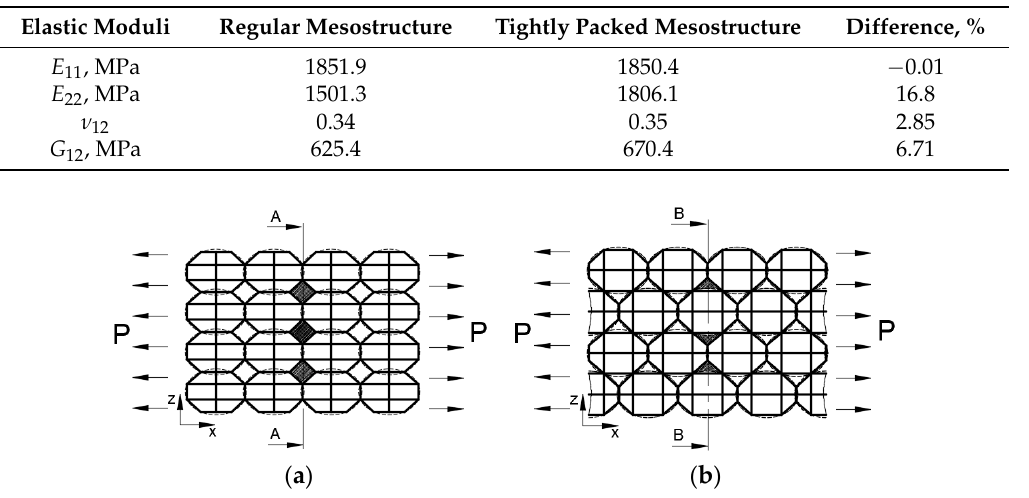
Figure 6. Mesostructure of the tensile specimen subjected to uniaxial load ( a ) regular; ( b ) tightly packed mesostructure.